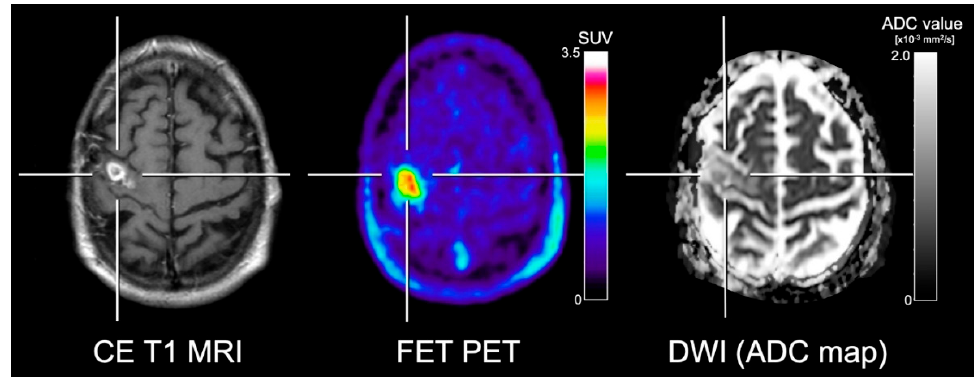
Figure 3. Contrast-enhanced (CE) T1-weighted MRI, FET PET and the apparent diffusion coefficient (ADC) map obtained from DWI in a patient with neuropathologically confirmed glioblastoma. In contrast to the ADC map, FET PET shows the metabolically active tumor tissue with high contrast. Furthermore, the ADC map shows slightly increased diffusivity in various subregions, erroneously indicating treatment-related changes.